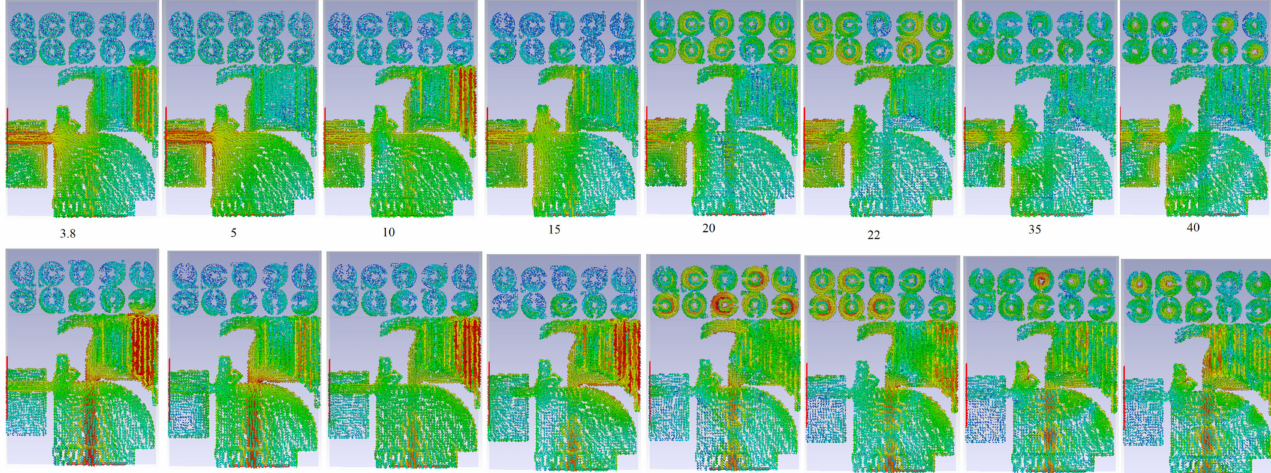
Figure 16. The SCD distribution of MTM-based MAVA at different frequencies: first row is for Ant1, and second row is Ant 2. The antenna radiation patterns (co-polarization on the x-z plane) generated and mea- sured for antenna 2 at various resonance frequencies are shown (Figure 17). Furthermore, for each mode of emission, the MTM-based MAVA had lower back radiations and side lobes than the original